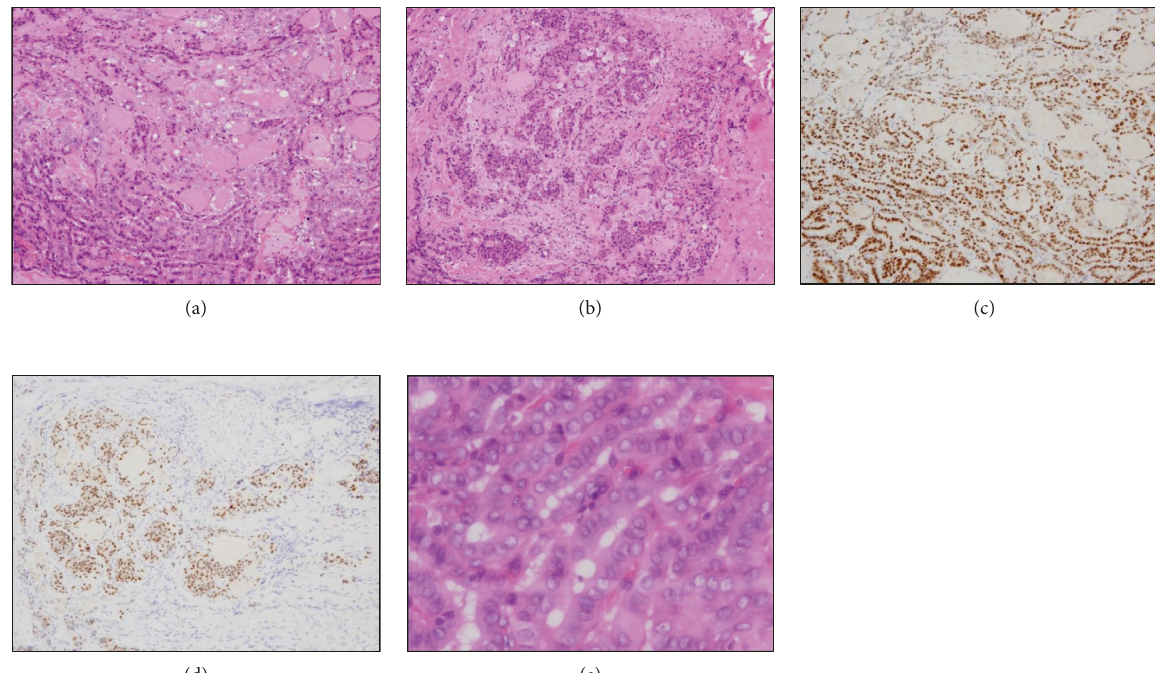
Figure 5: Histopathological (hematoxylin and eosin) and immunohistochemical findings for Sections B and C in Figure 3. Images (a), (c), and (d) are from Section B (thyroid papillary carcinoma), while images (b) and (d) are from Section C (poorly differentiated carcinoma) in Figure 3. (a) The tumor shows a ductal structure with funicular and microfollicular shapes, consistent with thyroid papillary carcinoma. (b) A honeycomb structure and necrosis are observed, with marked differences in nucleus sizes; these findings suggest poorly differentiated carcinoma. (c, d) Both papillary carcinoma and poorly differentiated carcinoma sites are thyroid transcription factor-1-positive. (e) Nuclear grooves under high